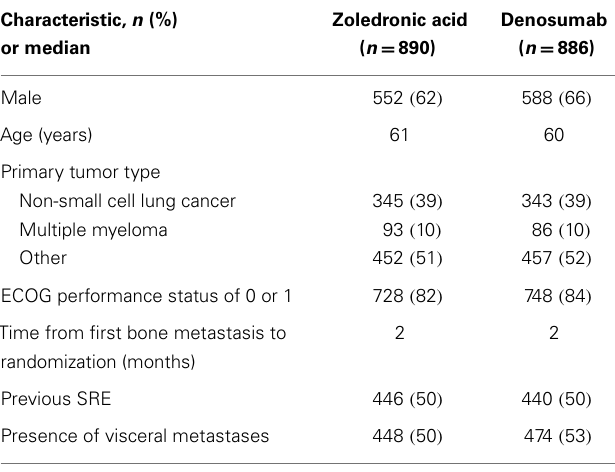
Table 1 | Baseline characteristics